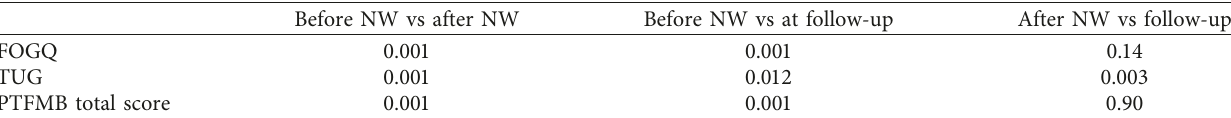
Table 4: Persistence of NW training effects assessed by FOGQ and TUG ( p values from the Nemenyi post hoc test). Before NW vs after NW Before NW vs at follow-up After NW vs